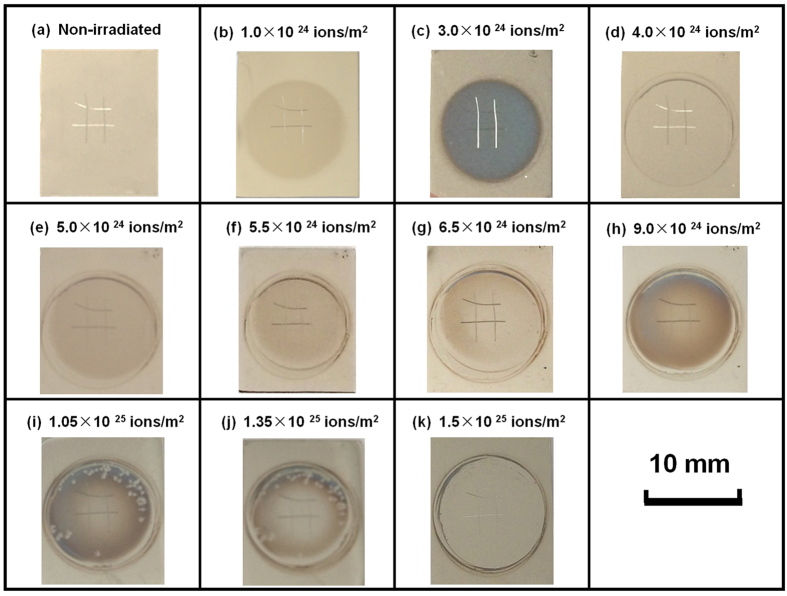
Photographs of W (100) crystal prior to H irradiation (a) and irradiated with 120 eV hydrogen ions at fluences of 1.0 × 1024–1.5 × 1025/m2 (b–k). This W specimen was marked for in-situ observation by a CCD camera and a SEM.